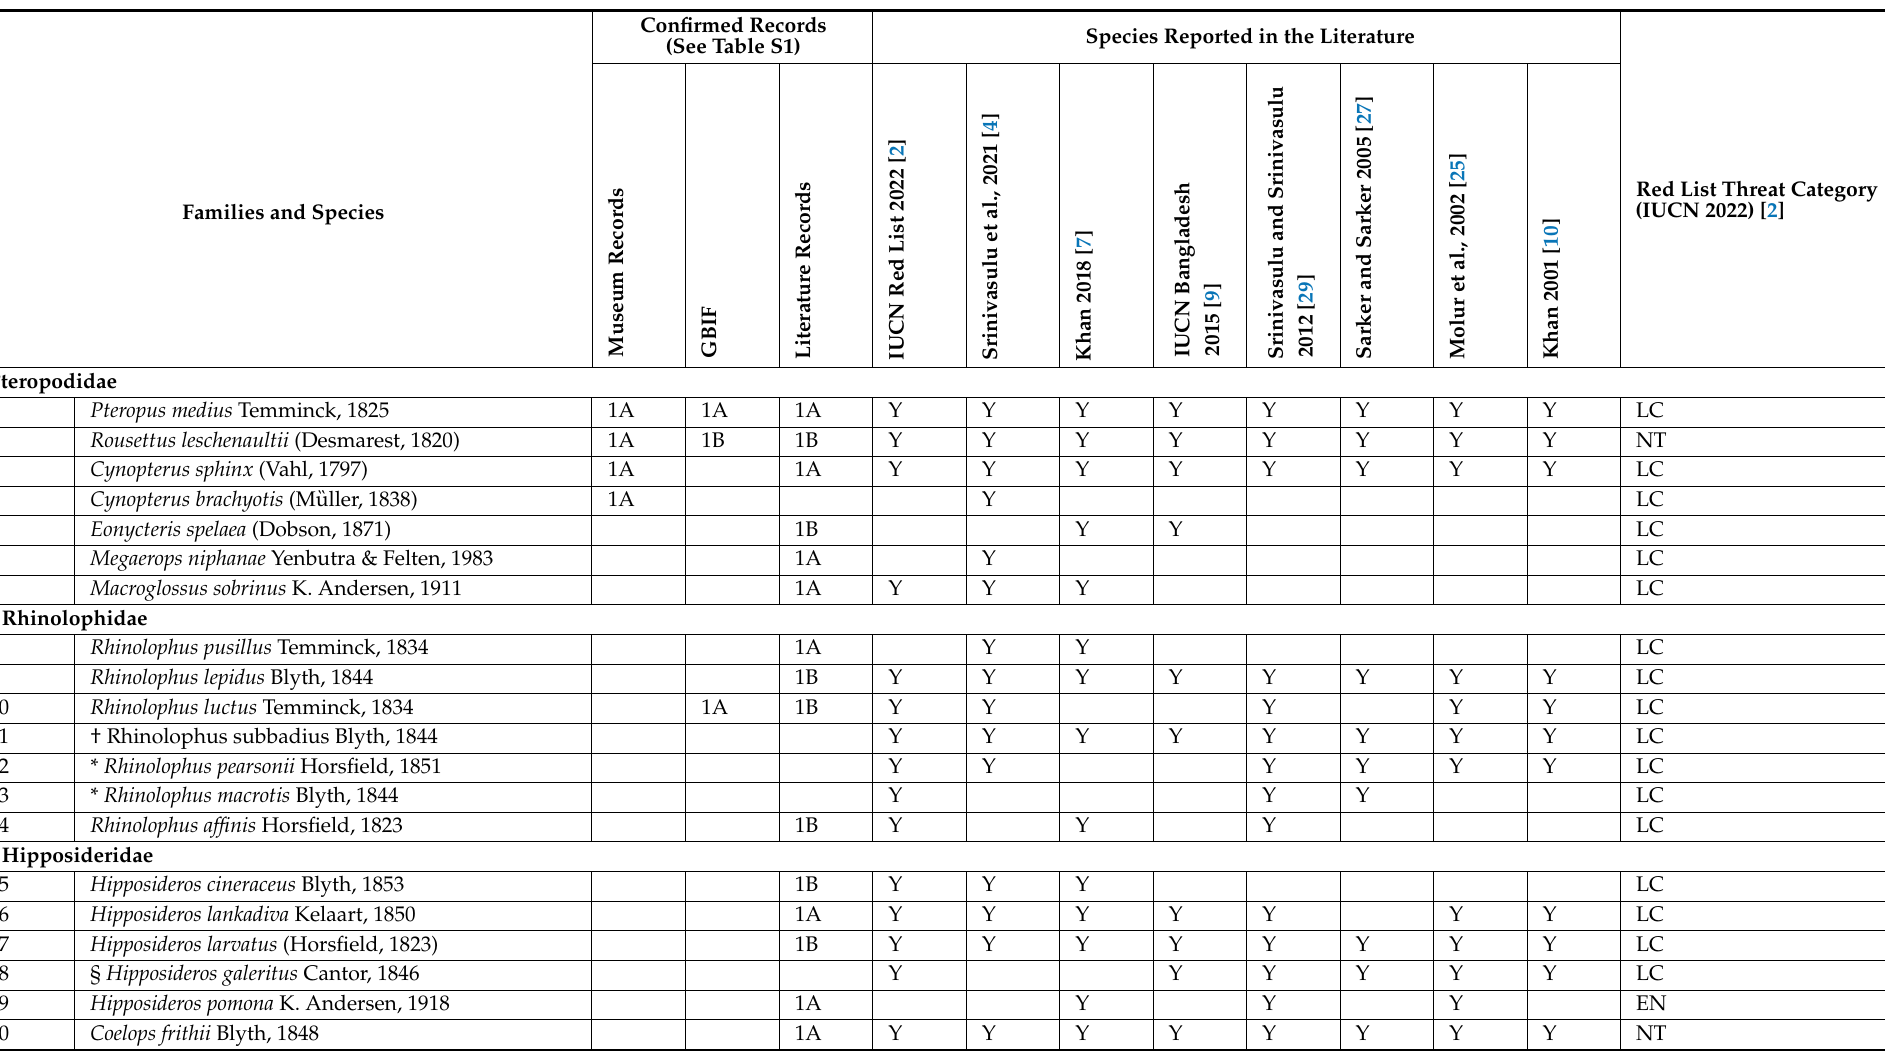
Species Reported in the Literature